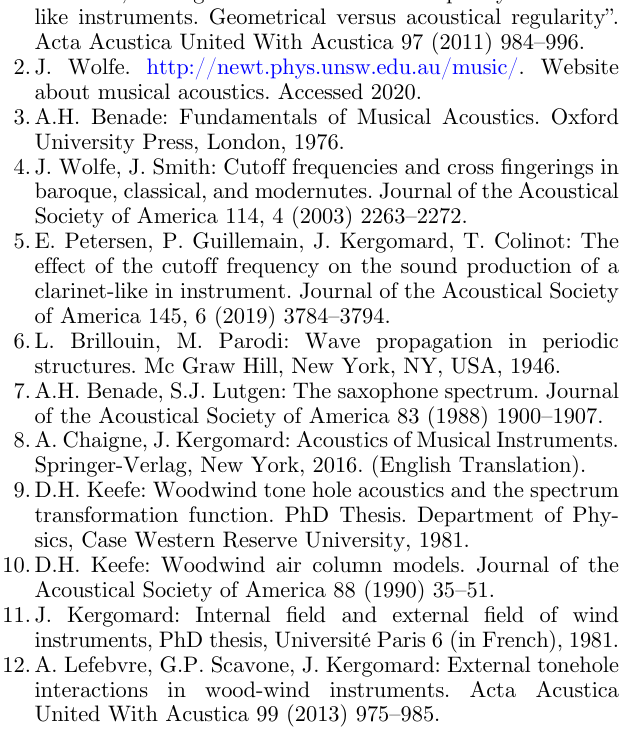
Figure 10. Comparison of three analysis methods. Successful asymmetric division (dark grey region) of an alto saxophone high C on left (written pitch, 311 Hz) and G ] on right (written pitch, 246 Hz) fi ngerings for different initial cell length ‘ L pair cell characteristic frequencies f P are denoted . The average of the fi rst three P -cells and of the entire lattice are provided c by D and h . The cutoff transition band f R is shown in light t